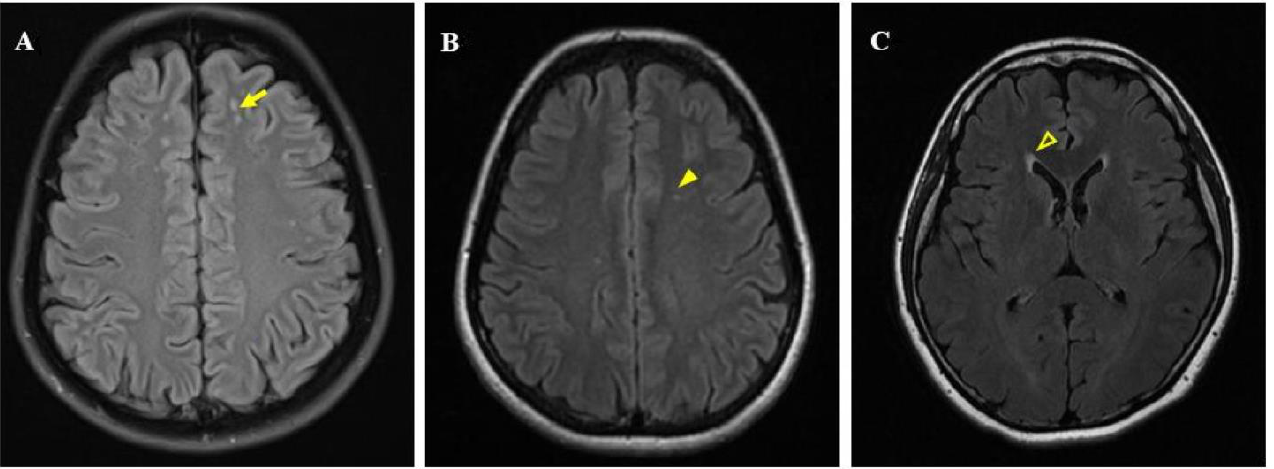
Figure 1. Fluid-attenuated inversion recovery images. ( A ) Near-cortical white matters (yellow ar- row), ( B ) deep white matter lesions (yellow solid arrow), and ( C ) paraventricular matter lesions (yellow hollow arrow).